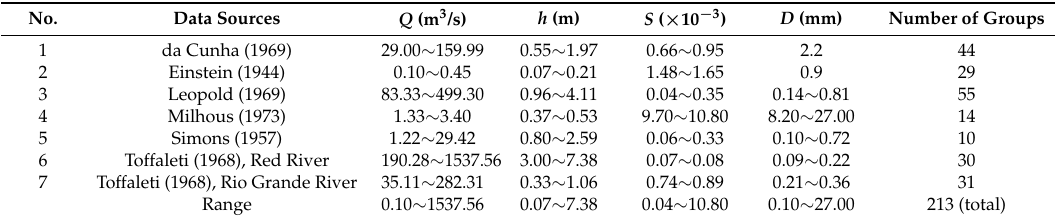
Table 1. Data sources and